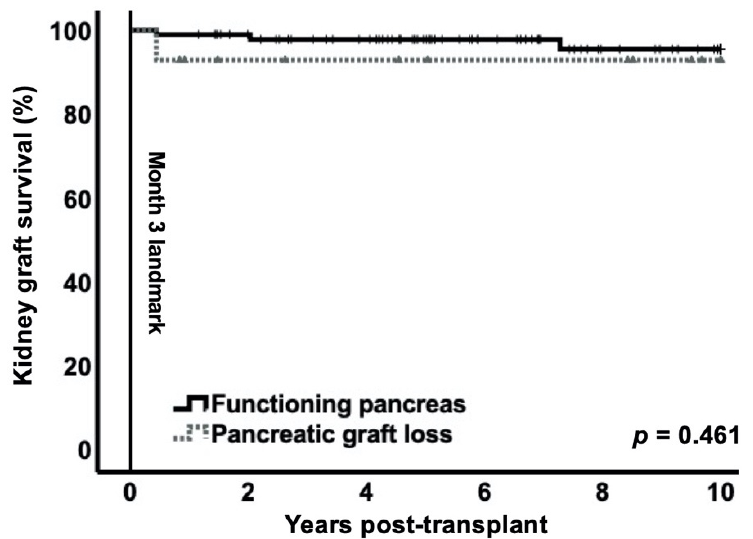
Figure 4. Kidney graft loss over 10 years censored for death with 3-month landmark for early pancreas graft loss. Kaplan–Meier curve showed no difference between the two groups ( p = 0.461).